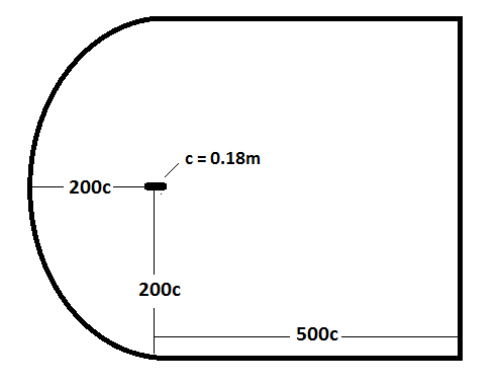
Figure 4. Topology and dimensions of spatial domain for RANS computations of NACA23012 case.